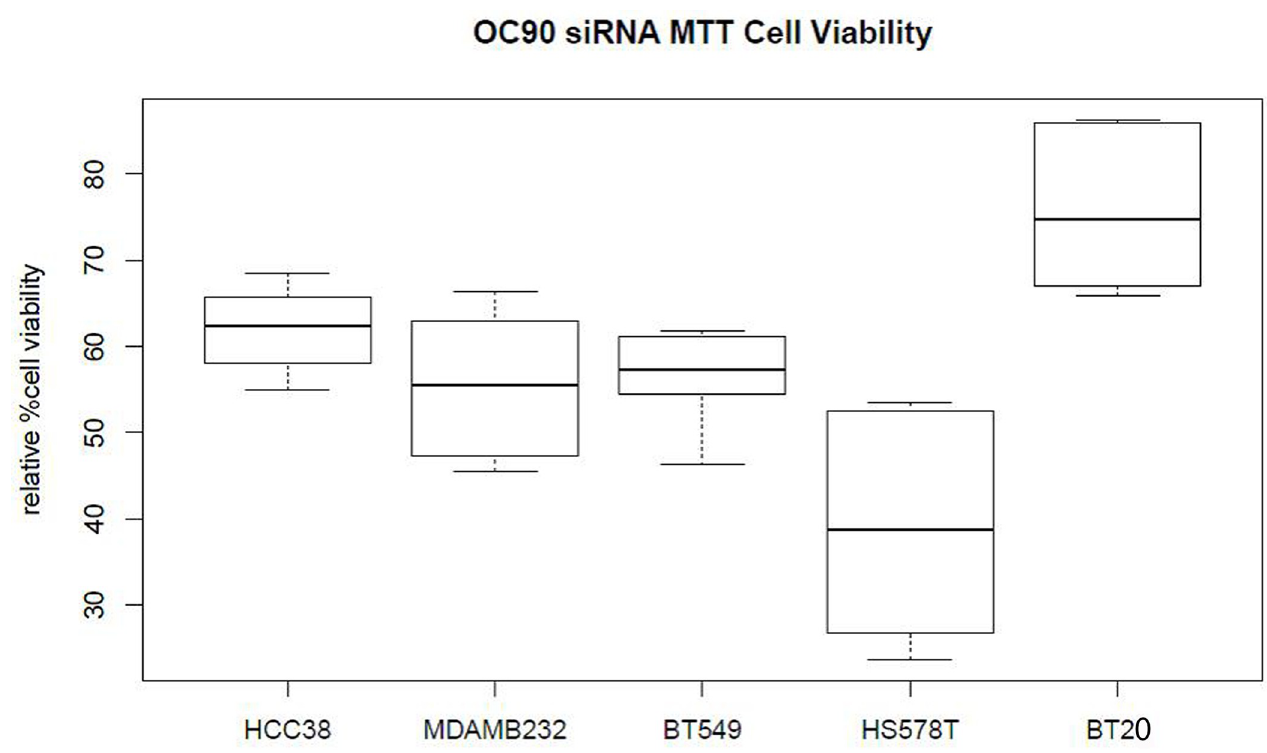
Fig 2. OC90 knockdown reduces cell viability in some of TNBC cell lines. Box plot shows the TNBC cell lines viability compared to that of control siRNA group.